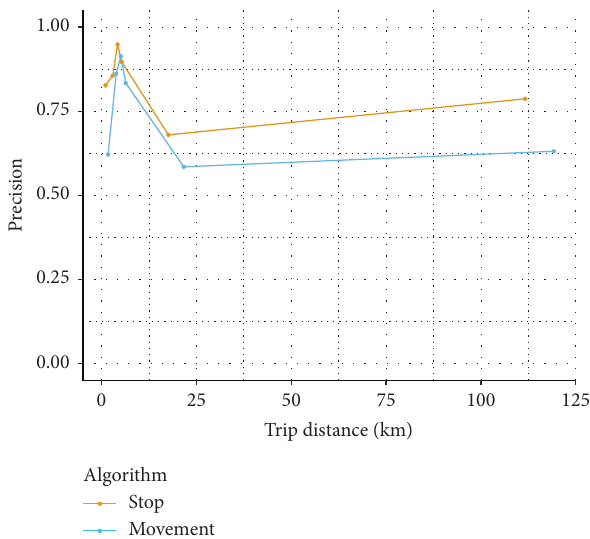
Figure 8: Precision depending on the trip distance. Each datapoint corresponds to 1/6 of the cellular trips and shows the share for which of these trips a matching Google trip was present.